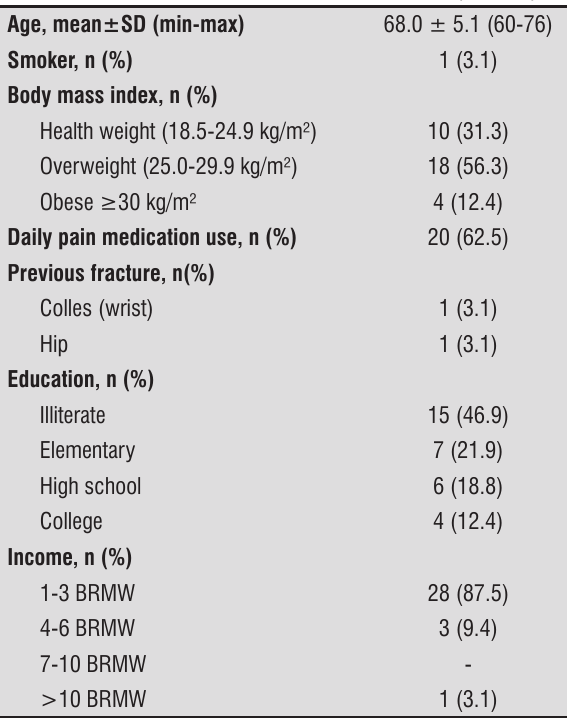
Table 2 - Frequency of older women with body function, body structure and activities and participation disabilities (n = 32) ICF Categories b152 Emotional